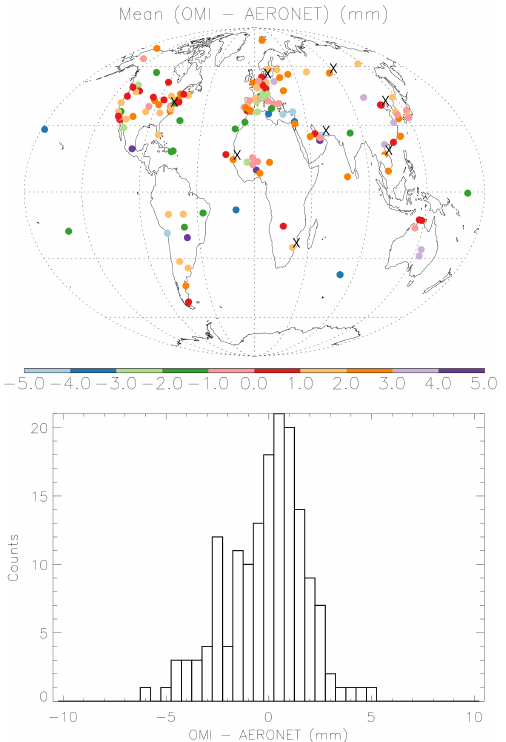
Figure 6. Top: spatial distribution of the time mean of version 1.0 OMI − AERONET from 2005 to 2009 at AERONET stations. Bot- tom: histogram (with 0.5mm bins) for the values in the top panel. Figure 7. Top: 2-D normalized histograms for (left) land and (right)